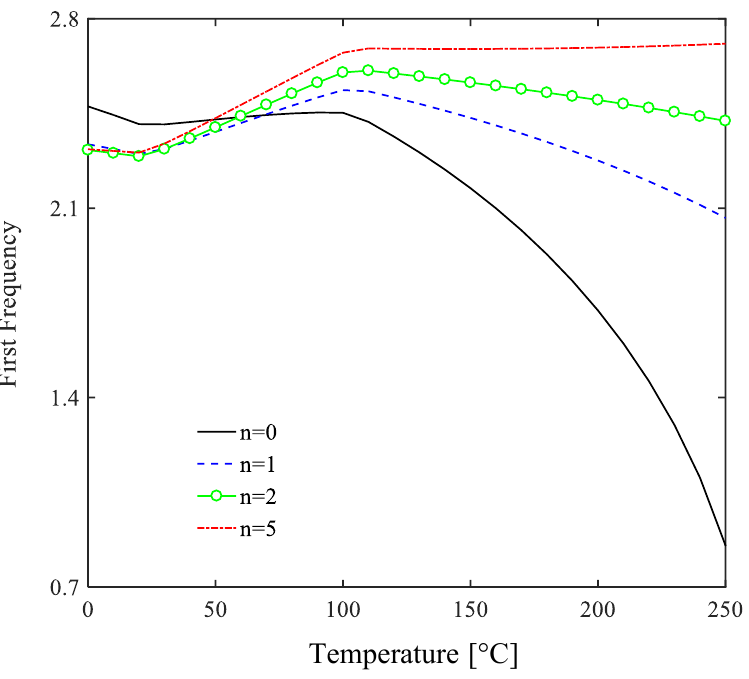
Figure 12. Variation of the first dimensionless frequency vs. temperature for different FGM volume fractions and a uniform temperature ( V SMA = 0.4, h c / h = 0.5 and ε 0 = 2%).